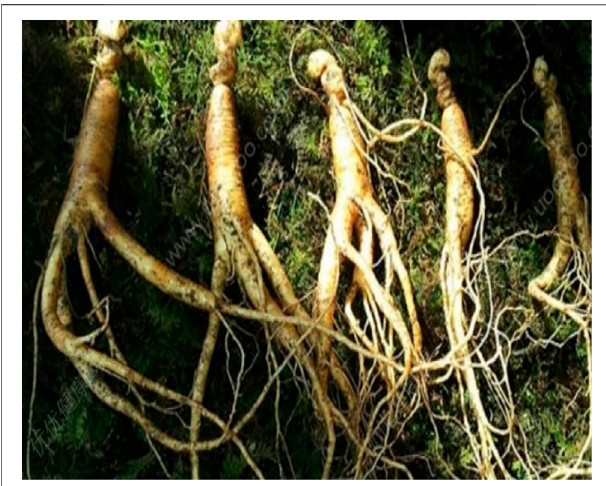
FIGURE 1 | The photo of Ginseng. The photo of Ginseng collected from Jilin province, one of major production regions of Ginseng in China.